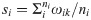
Scores for each of the questions with respect to career experience.The data set includes responses from pure and applied sciences and natural sciences and excludes those from Asia and Africa. The questions were organized from lowest to highest score based on the answers of the professionals with 5 years of experience where ni is the number of responses for each of the 4 categories of experience and si=Σiniωik/ni.